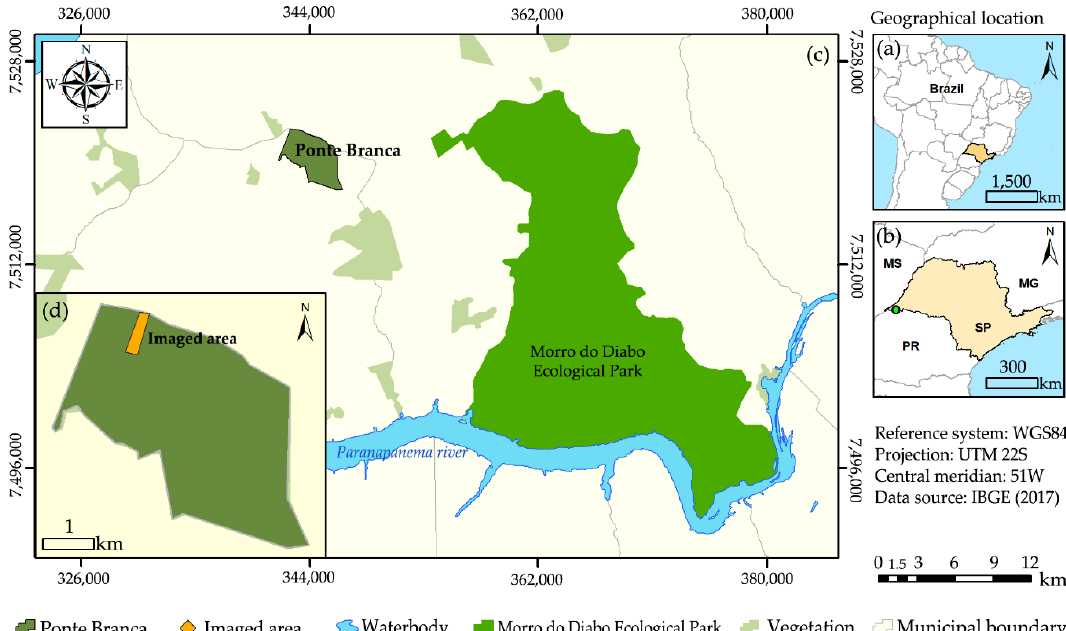
Figure 1. Study area in ( a ) Brazil, ( b ) São Paulo, ( c ) the western region of the São Paulo state, and ( d ) Ponte Branca forest fragment.